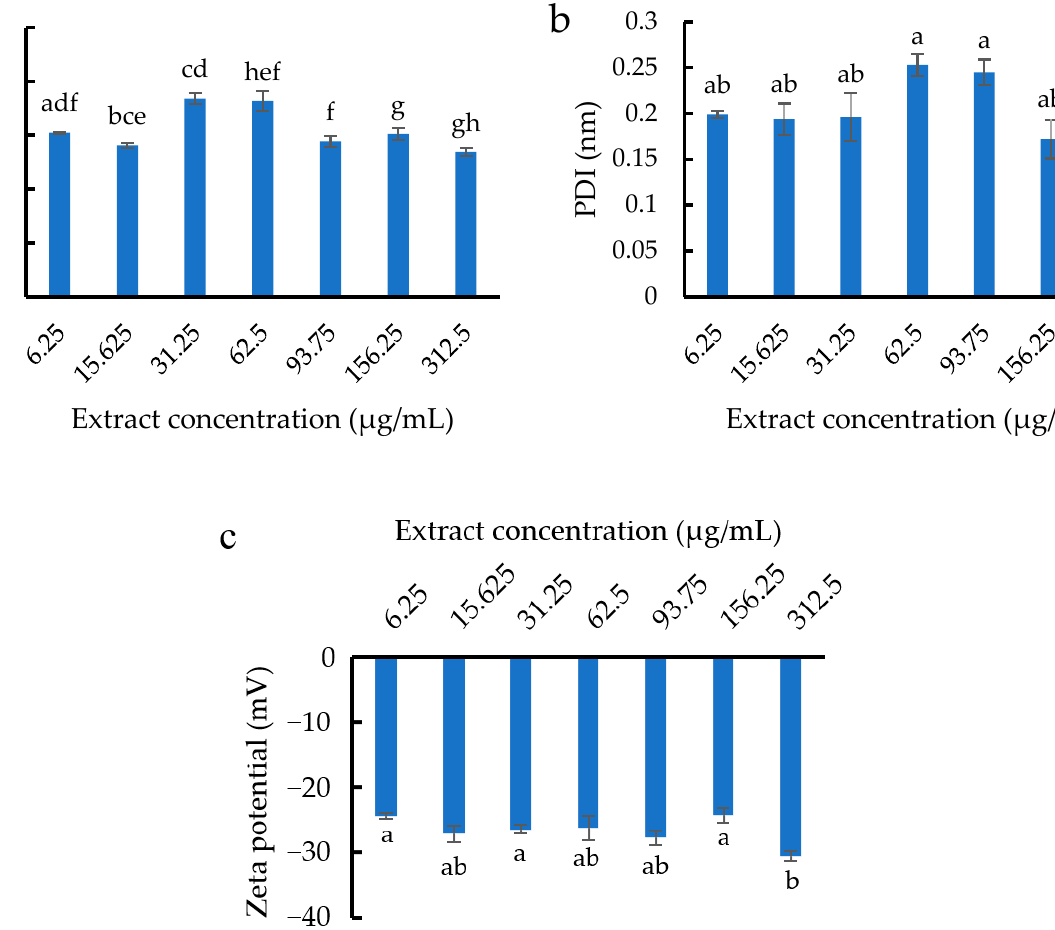
Figure 3. ( a ) Vesicle size, ( b ) size distribution, and ( c ) zeta potential of ethosomes loaded with different concentrations of Z. zerumbet (L.) rhizome extract. Different letters above the error bars indicate significant differences at the 0.05 level (ANOVA and post hoc test).